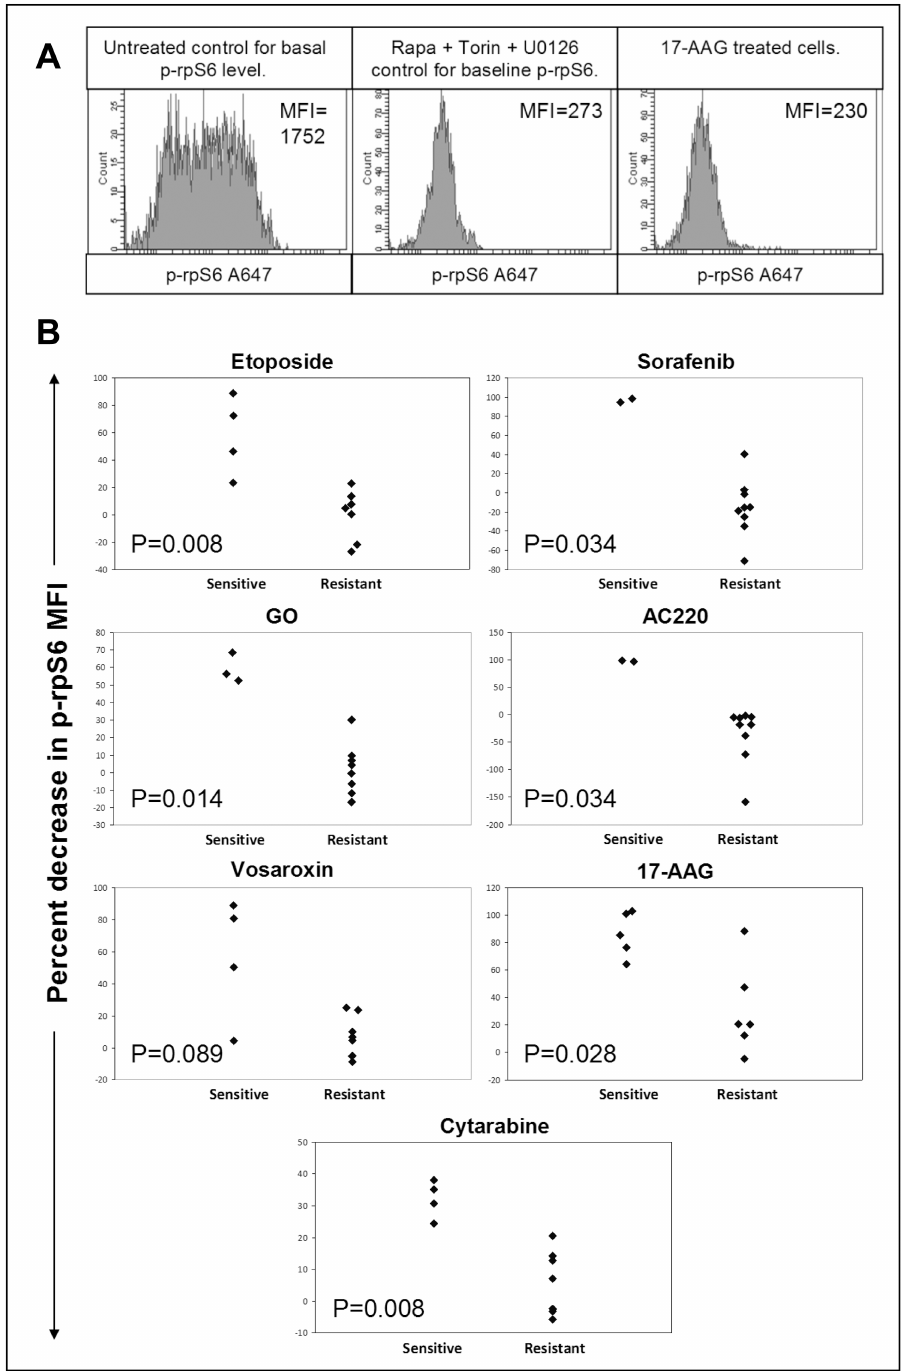
Fig 2. RpS6 dephosphorylation at 4 hours predicts 48 hour drug sensitivity. (A) MOLM-13 cells were cultured for 4 hours with 100 nM Rapamycin, 1 μM torin1 and 3 μM U0126 to determine p-rpS6 baseline. RpS6 dephosphorylation after 4 hours culture with 500 nM 17-AAG is also shown. Example histograms are representative of 3 individual experiments. (B) Based on the 48 hour IC 50 values a drug sensitive/resistant cut off for cell lines was determined. Cell lines were cultured for 4 hours with 1 μM etoposide, 50nM sorafenib, 600ng/ml GO, 10nM AC220, 1 μM vosaroxin, 500nM 17-AAG and 2 μM cytarabine. Values are a percent of untreated cell p-rpS6 as described in the methods. Each point represents a cell line and is the product of three individual